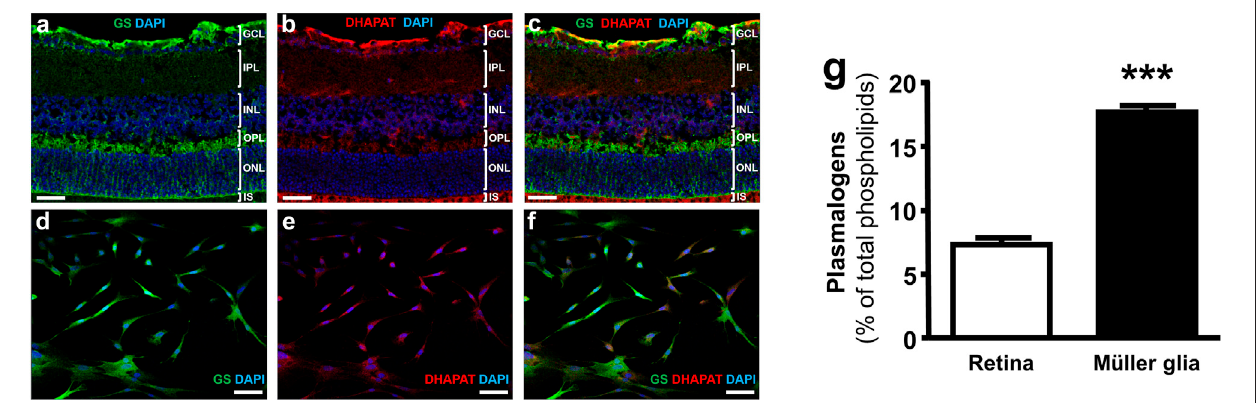
FIGURE 3 | Müller glia express DHAPAT and concentrate plasmalogens in the retina. (A – C) Immunohistochemical staining of glutamine synthetase (GS) and DHAPAT in retinal slices. GS expression pattern con fi rmed the radial Müller cells localization (A,B) . DHAPAT-positive cells showed a strong expression pattern in the ganglioncells layer (GCL), theinner nuclear layer (INL) and photoreceptors inner segments (IS) (B,C) ,corresponding tothe localization ofMüllercells endfeet, Somaand distal processes, respectively. (D – F) Micrographs of primary rat Müller cells labeled with GS and DHAPAT primary antibody showing that GS-positive Müller cells also displayed a strong expression of DHAPAT. (G) Plasmalogen quanti fi cation by GC-FID reveals a strong concentration in Müller glia compared to whole retina extracts,suggestingaparticularfunctionoftheseether-lipidsintheirphysiology. n =10.Mann&Whitneytest.*** p < 0.001.Datashownasmean±SEM.GCL=ganglion cell layer; IPL = inner plexiform layer; INL = inner nuclear layer; ONL = outer nuclear layer; OS = outer segments of the photoreceptors. Scale bars = 50 µM.